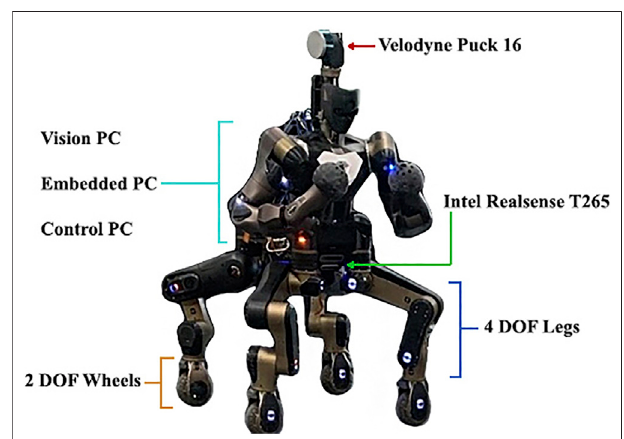
FIGURE 7 | The CENTAURO hybrid legged/wheeled robotic platform withindicationsofitsmobilitysystem,perceptionandonboardcomputational